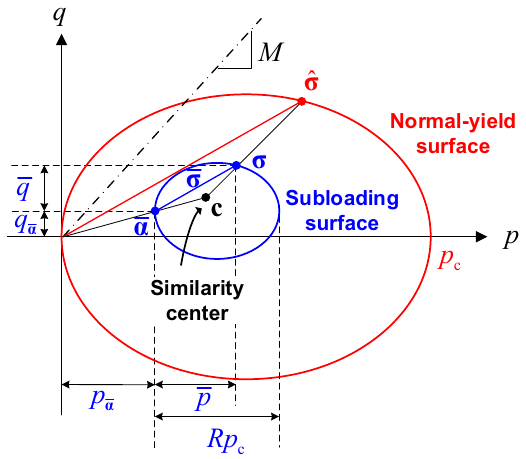
Figure 1. The relationship of subloading surface and normal-yield surface in p − q